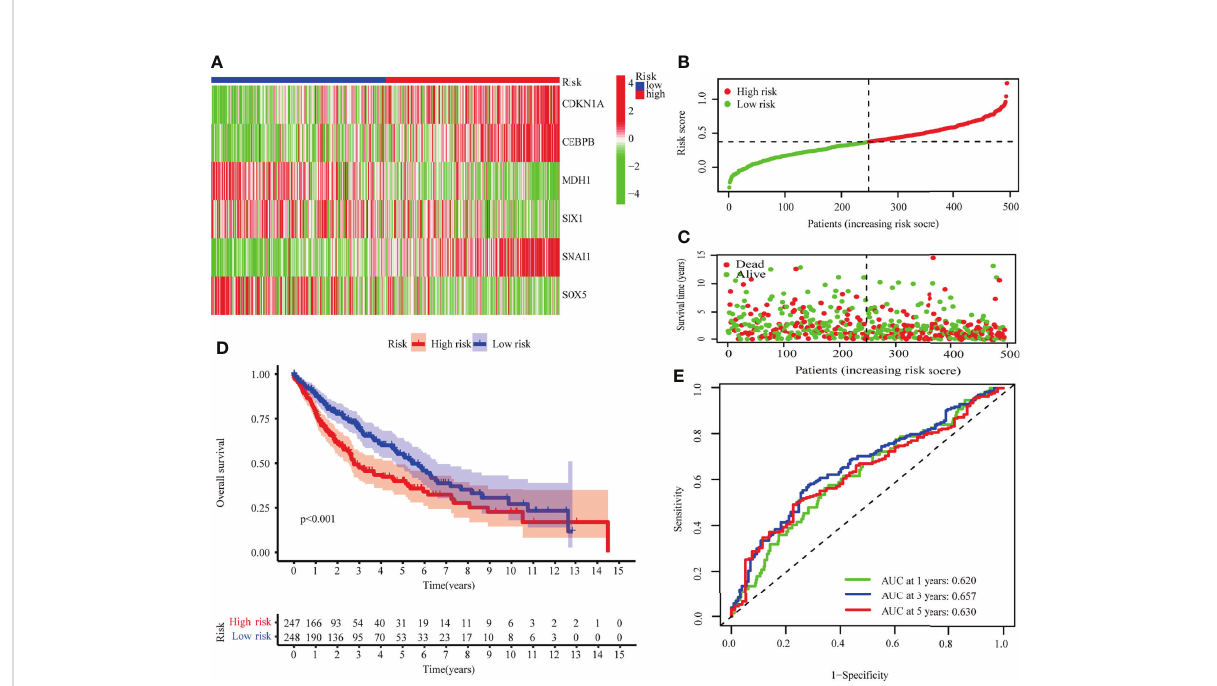
FIGURE 3 The TCGA-LUSC cohort was used to develop a risk model. (A) A heatmap of six hub genes involved in cellular senescence. (B) The TCGA cohort ’ s risk scores. (C) Survival status distribution. (D) Survival analysis of high and low risk groups. (E) The risk model ’ s AUC.